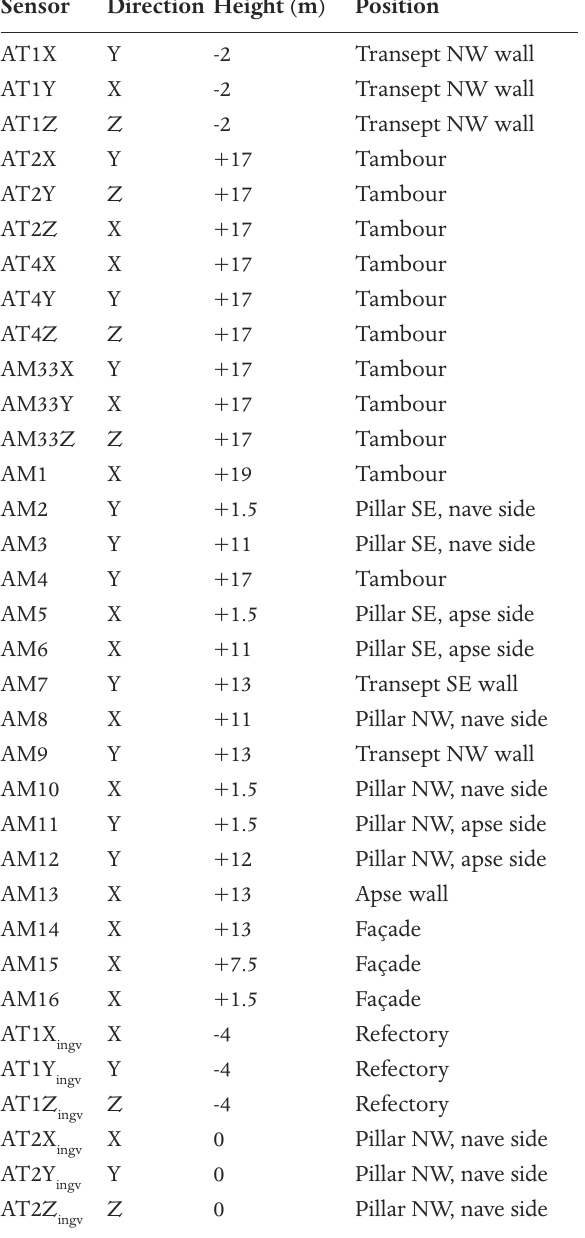
Table 1. List of sensors used in this study. Column #3 shows the height of the installation. The codes AT* and AM* indicate the mono- and tri- axial accelerometers, respectively. AT1 the two Reftek-130 digitizers coupled to Lennartz Le3D-5s seis-